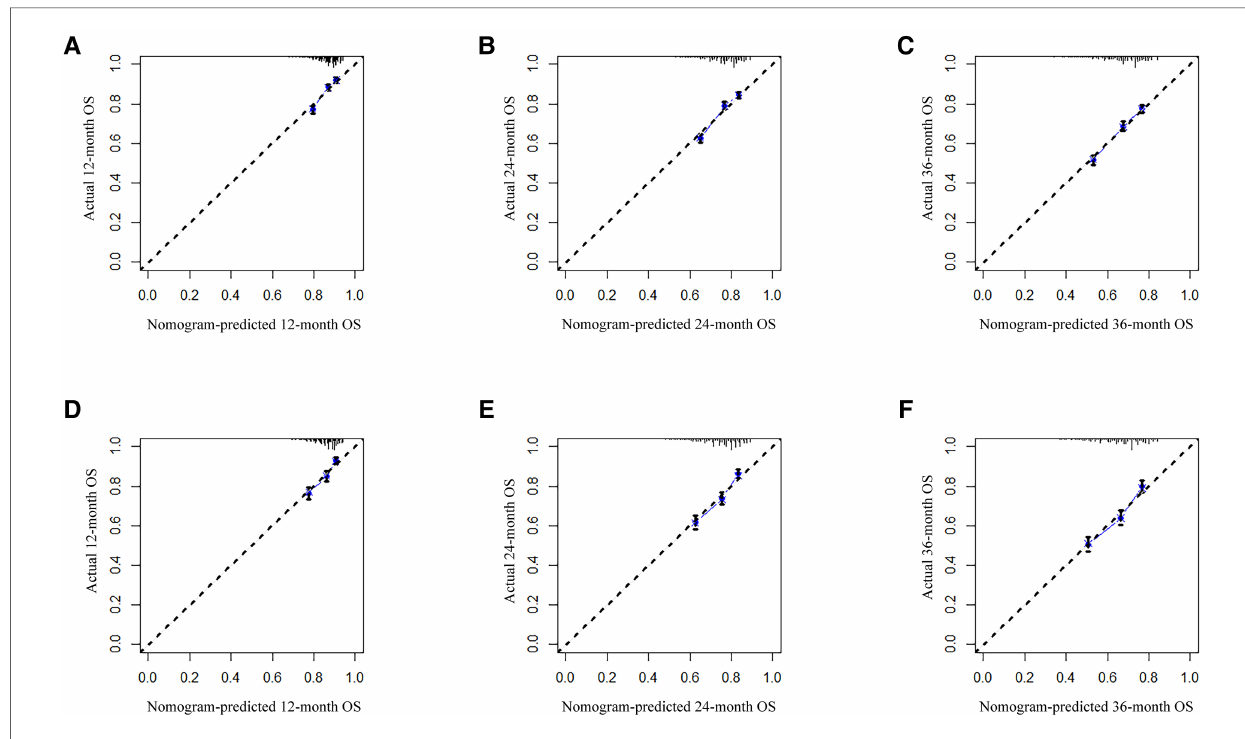
FIGURE 3 Calibration curves for predicting patient OS at 1-, 2- and 3-year timepoints in training ( A – C ) and validation ( D – F ) cohorts, respectively. The 45-degree line represents an ideal match between actual ( y -axis) and predicted ( x -axis) survival. OS, overall survival.